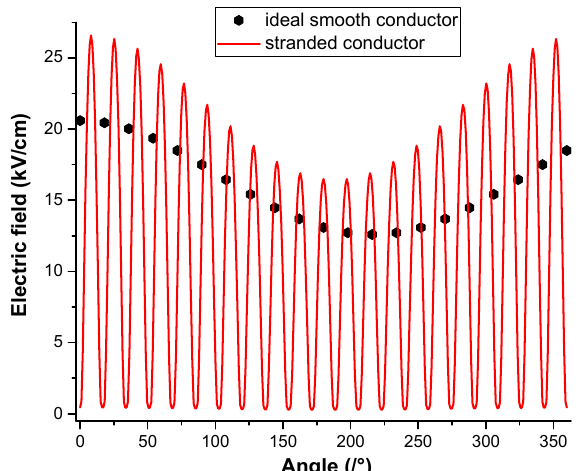
Figure 10. Comparative analysis of surface electric field on a sub-conductor: smooth vs. stranded conductors. Table 9. Equivalent roughness coefficient under different weather